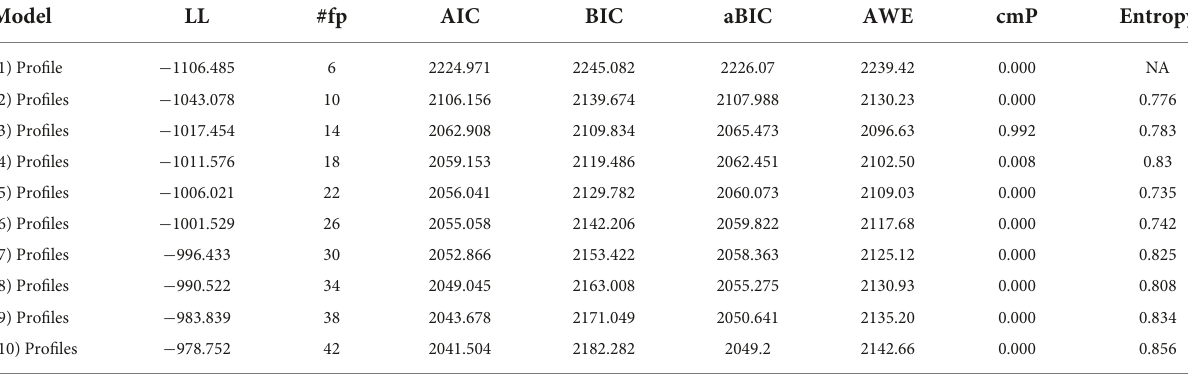
TABLE 1 Statistical results from the latent profile analysis ( t 1 ).